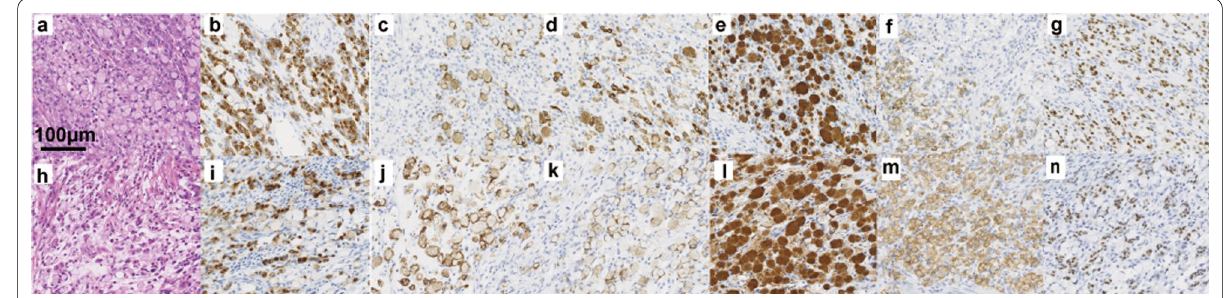
Fig. 4 Histopathological findings of the colon tumor ( a – g ) and previously resected gastric cancer ( h – n ). The colon tumor consisted of signet ring cell carcinoma that mainly existed in the submucosa ( a ). The tumor cells were similar to the previously resected gastric cancer (hematoxylin–eosin staining) ( h ). The tumor cells of the colon tumor were positive for CD10 ( b ), focally positive for MUC2 ( c ), positive for MUC5AC ( d ), HGMucin ( e ), focally positive for MUC6 ( f ), and positive for CDX2 ( g ). The tumor cells of the gastric tumor were positive for CD10 ( i ), focally positive for MUC2 ( j ), MUC5AC ( k ), HGMucin ( l ), MUC6 ( m ), and CDX2 ( n